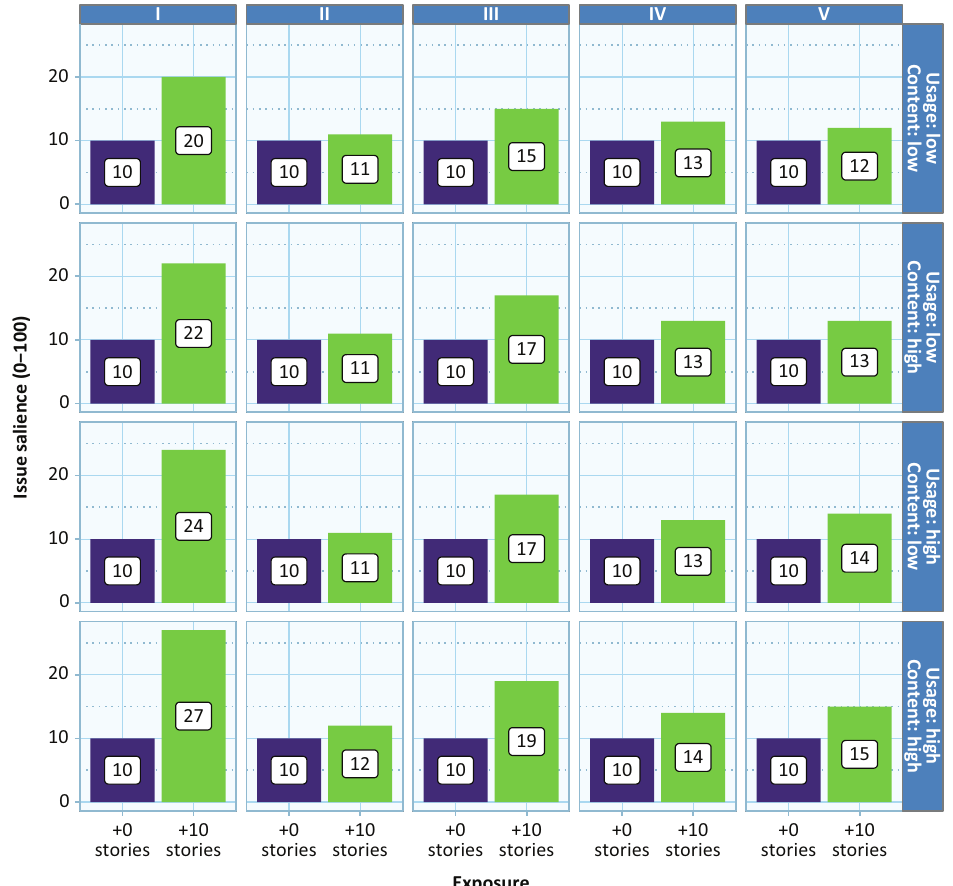
Figure 2. Predicted salience of issue if exposure to issue increases by 10 news stories. Media and Communication, 2022, Volume 10, Issue 3, Pages